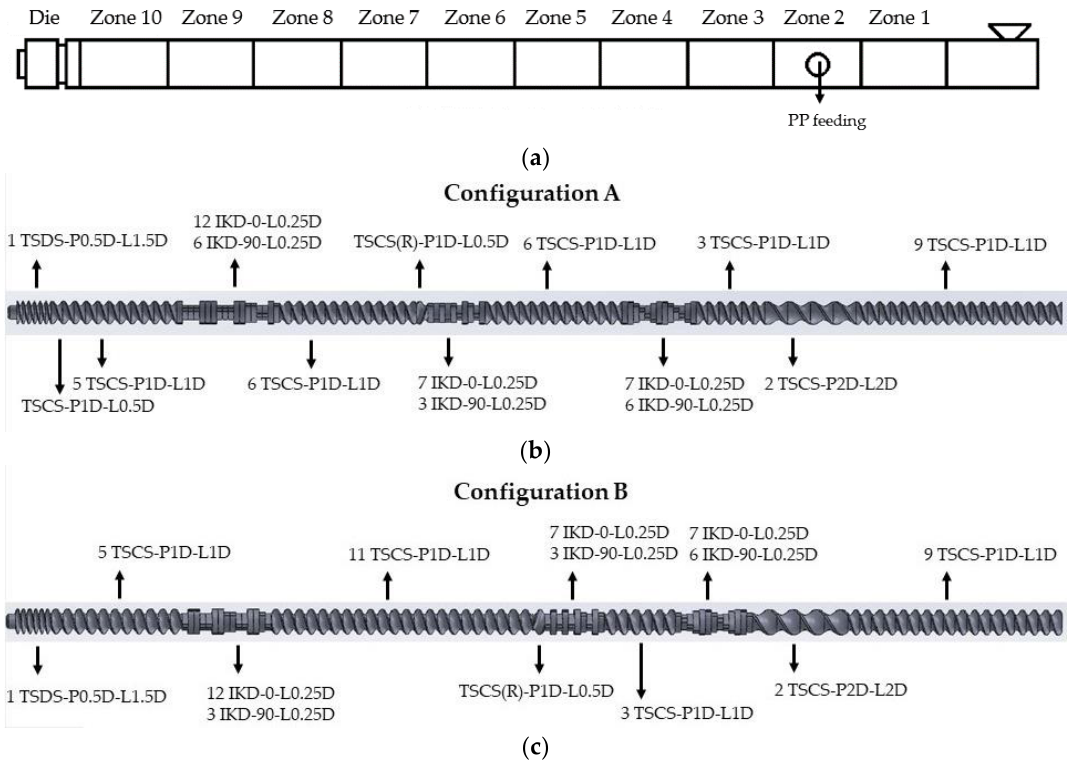
Figure 2. Extruder zones and screw configurations: ( a ) Location of the zones along the extruder; ( b ) Screw configuration A; ( c ) Screw configuration B. Designations of the screw modules ( D stands for the diameter of the screw): TSCS-P1D-L1D: twin-start conveying screw, pitch 1 D , length 1 D ; TSCS(R)-P1D-L1D: twin-start conveying screw (reverse flight), pitch 1 D , length 1 D ; TSCS-P2D-L2D: twin-start conveying screw, pitch 2 D , length 2 D ; IKD-0-L0.25D: individual kneading disc, length 0.25 D , 0° angle; IKD-90-L0.25D: individual kneading disc, length 0.25 D , 90° angle (each kneading disc can be rotated and positioned in 60° steps on the screw, so utilizing a 0° and a 90° kneading element allowed us to build kneading blocks with individual discs having a 30° angle difference compared to the neighboring blocks: 0°, 60°, 120°; 180°; 240° and 300° was achieved with discs with a 0° angle, while 30°, 90°, 150°, 210°, 270° and 330° was achieved with discs with a 90° angle); TSDS-P0.5D-L1.5D: twin-start discharge screw, pitch 0.5 D , length 1.5 D .